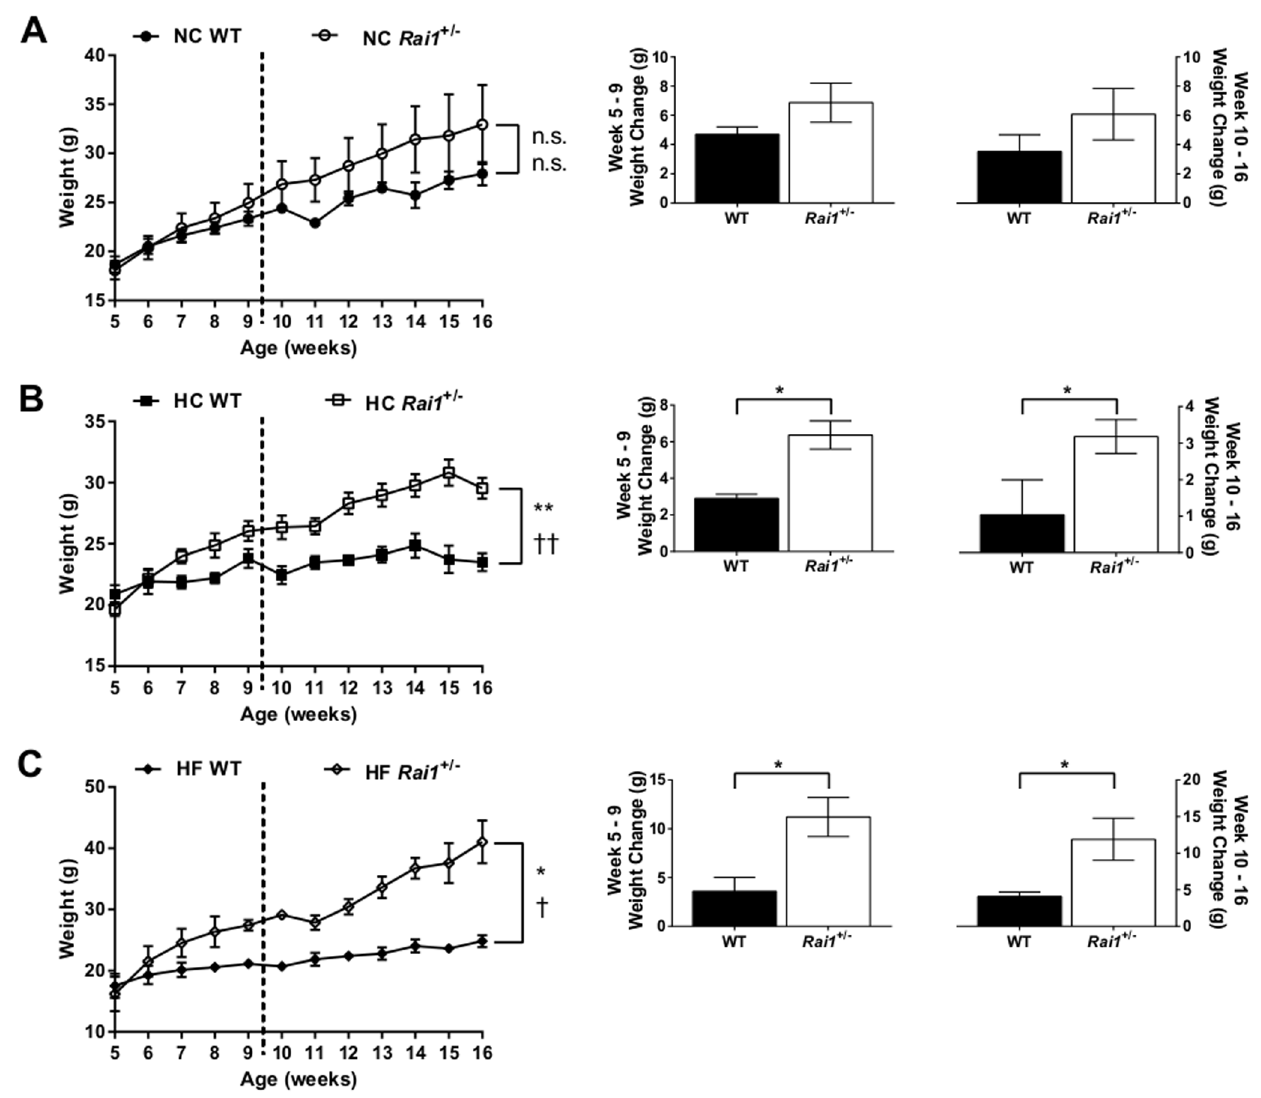
Figure 2. High carbohydrate and high fat diets alter growth rates in Rai1 + / 2 mixed background mice. ( A ). All mice fed a normal chow diet had similar growth rates during adolescence (weeks 5–9) or adulthood (weeks 10–16). No significant difference was observed in the amount of weight gained during each developmental stage. ( B ). Rai1 + / 2 mice fed a high carbohydrate diet had significantly faster growth during adolescence and adulthood relative to wild type mice. Rai1 + / 2 mice gained significantly more weight during adolescence and adulthood relative to wild type. ( C ). Rai1 + / 2 mice grew significantly faster and gained more weight when fed a high fat diet during both adolescent and adult stages of development relative to wild type mice. All data are plotted as means + / 2 SEM; dashed line represents the separation between developmental stages. Left panel; adolescence (weeks 5–9); n.s.=not significant; * P , 0.05; ** P , 0.01; adulthood (weeks 10–16); n.s.=not significant; { P , 0.05; {{ P , 0.01. Right panel; * P , 0.05. NC: WT n=4, Rai1 + / 2 n=8. HC: WT n=3, Rai1 + / 2 n=7. HF: WT n=4, Rai1 + / 2